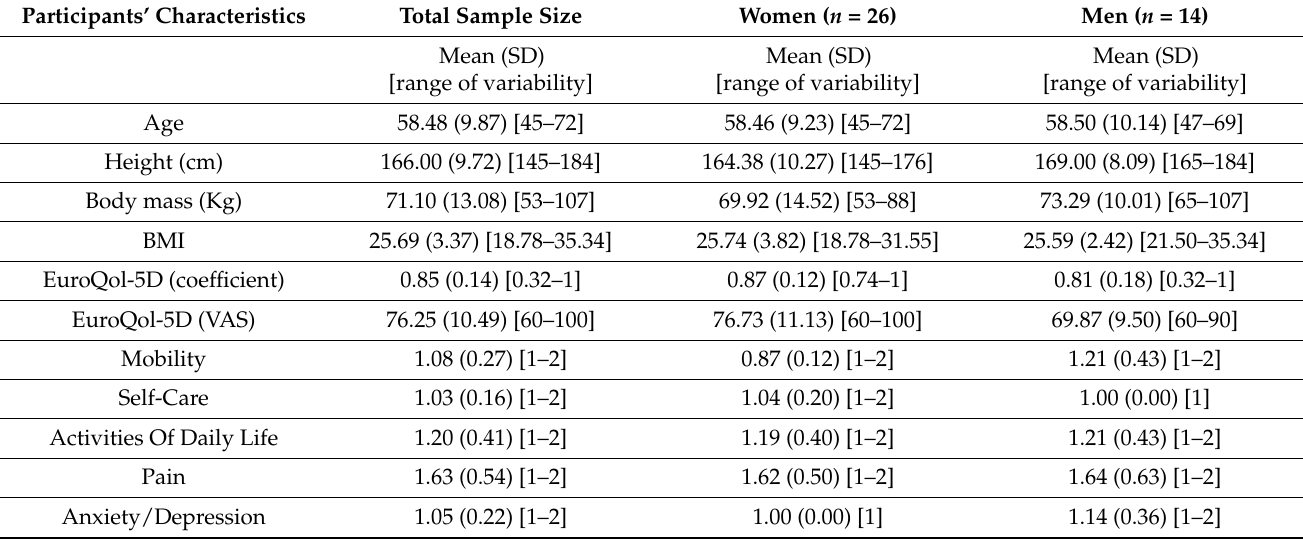
Table 2. Participants’ physical and quality-of-life characteristics.